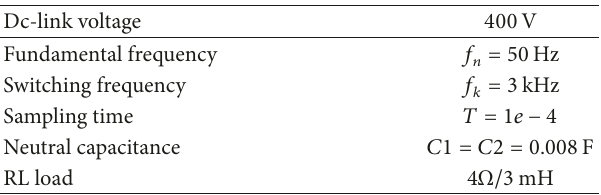
Table 4: Experimental